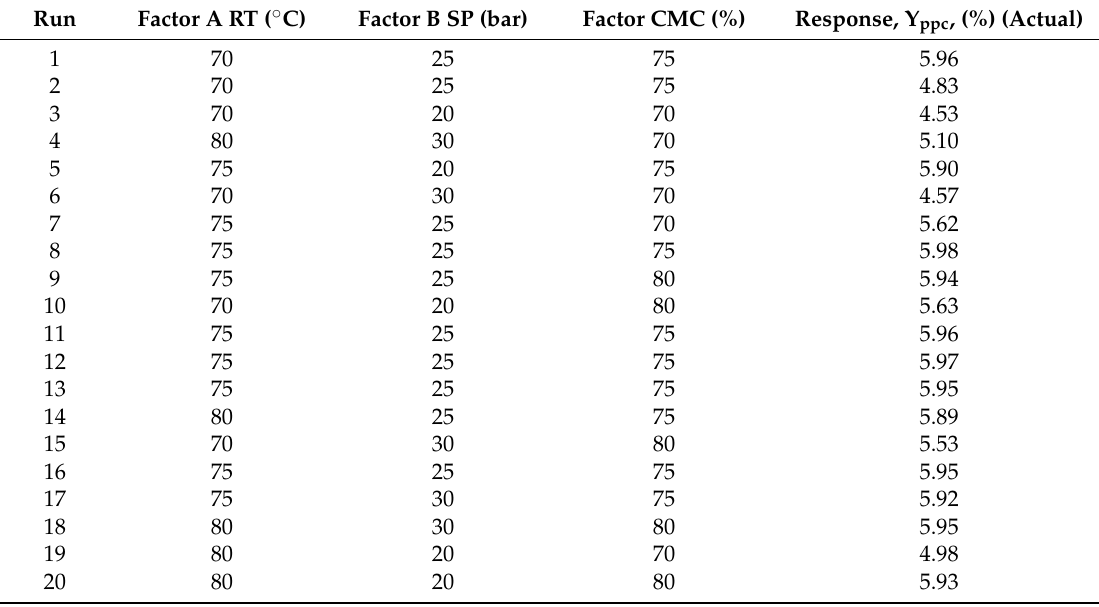
Table 3. Experimental design and results of the response surface